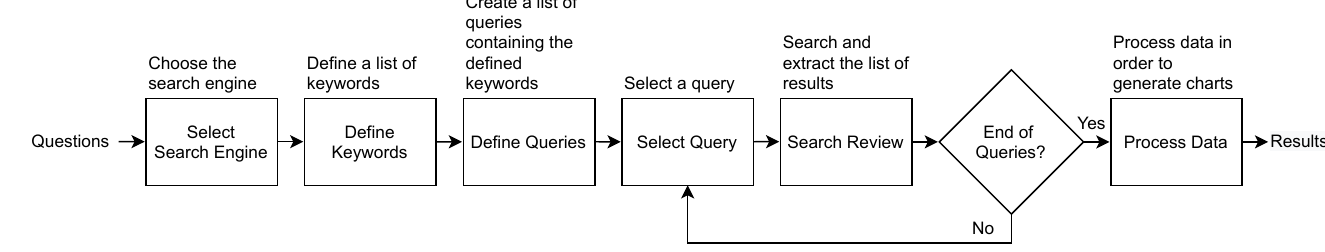
Figure 3. Systematic Process